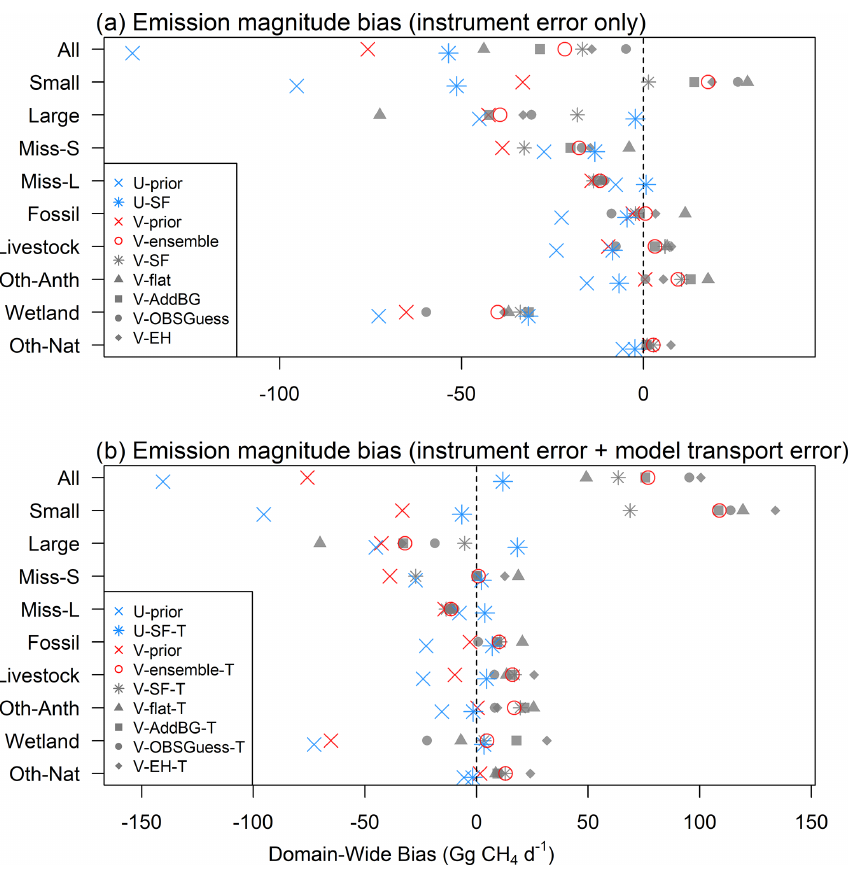
Figure 6. Inversion performance in terms of domain-wide emission bias for (top to bottom): all grid cells, small sources ( < 50mgm − 2 d − 1 ), large sources ( ≥ 50mgm − 2 d − 1 ), small missing sources (prior < 10mgm − 2 d − 1 ; truth ∈ [10, 50)mgm − 2 d − 1 ), large missing sources (prior < 10mgm − 2 d − 1 ; truth ≥ 50mgm − 2 d − 1 ), and fossil fuel, livestock, other anthropogenic, wetland, and other natural emissions. Panel (a) shows results for synthetic observations subject to instrument error only, while panel (b) shows results that also include model transport